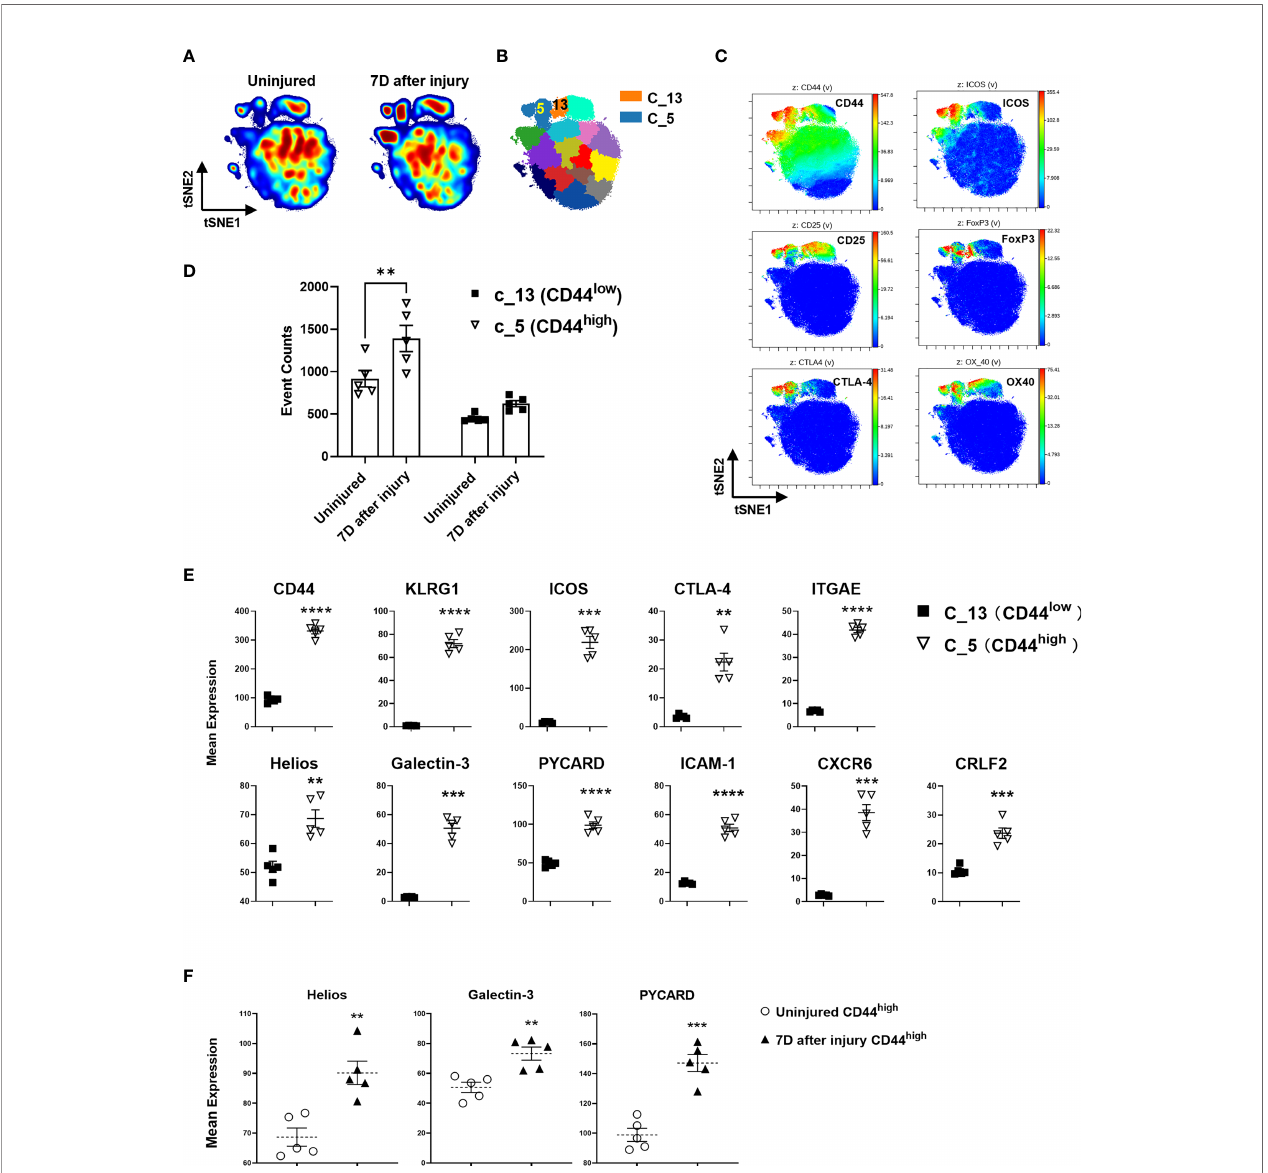
FIGURE 5 | CyTOF validation of protein expression of DE genes on Treg subsets identi fi ed by RNA sequencing. (A) Representative density contour tSNE plots generated by 39-marker CyTOF staining of equal-sampled gated CD3 + /CD4 + T cells from the lymph nodes of uninjured and injured mice, and (B) unsupervised computational clustering by SPADE showing phenotypic clusters as patchwork colors. Clusters 5 and 13 (C_5, C_13) are Treg subset clusters. (C) tSNE plots colored by the indicated antibody staining channel con fi rming the identi fi cation of CD44 high and CD44 low Treg subsets as well as other canonical Treg identifying markers. (D) Event counts from cluster 5 and 13 comparing changes in uninjured and injured mice at day 7. Bars represent the means ± SEM. Data were analyzed by two-way ANOVA, interaction P=not signi fi cant. Signi fi cant comparison by Sidak ’ s multiple comparisons test is denoted by ** P=0.005 (CD44 high cluster 5, injured versus uninjured) (E) Mean expression levels of select protein markers detected by CyTOF corresponding to DE genes in CD44 high and CD44 low Tregs that were identi fi ed by RNA sequencing. (F) The impact of injury on the expression of Helios, Galectin-3, and PYCARD in CD44 high Tregs 7 days after injury as measured by CyTOF staining. Bars represent the mean ± SEM of mean expression intensity levels. Data were analyzed by two-tailed unpaired t test and signi fi cance compared with uninjured control denoted by ** P < 0.01, *** P < 0.001, and **** P < 0.0001. Data represent 2 independent experiments (n=5 mice per